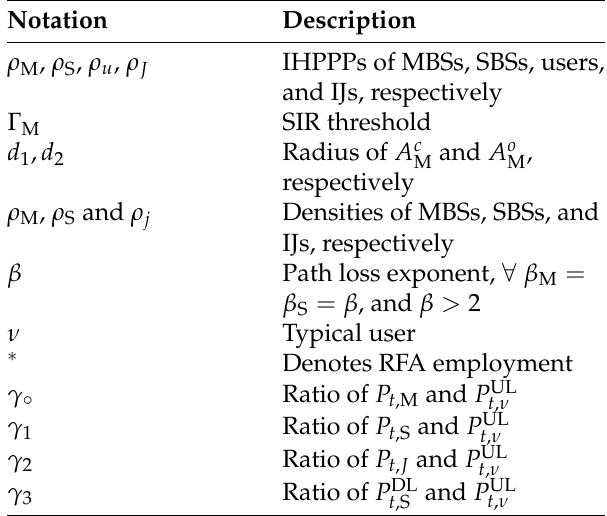
Table 2. Notation